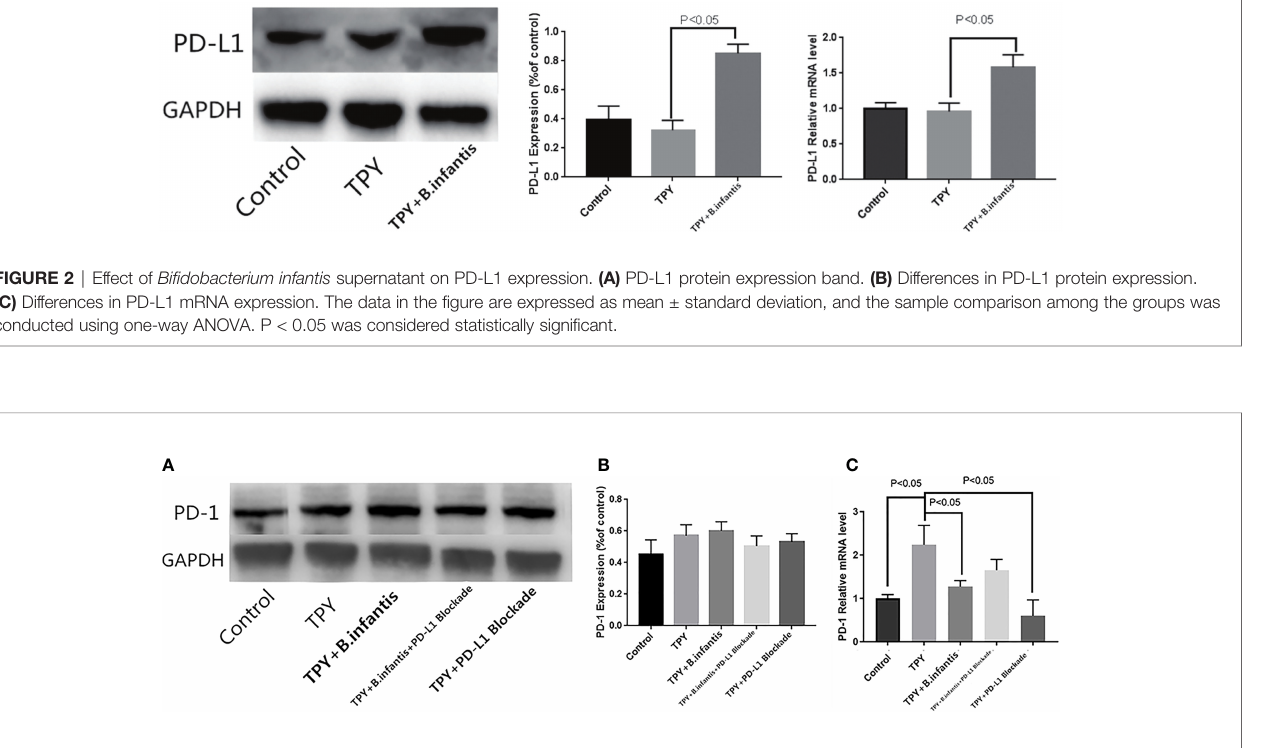
FIGURE 3 | Effect of Bi fi dobacterium infantis supernatant on PD-1 expression. (A) PD-1 protein expression band. (B) Differences in PD-1 protein expression. (C) Differences in PD-1 mRNA expression. The data in the fi gure are expressed as mean ± standard deviation, and the sample comparison among the groups was conducted using one-way ANOVA. P < 0.05 was considered statistically signi fi